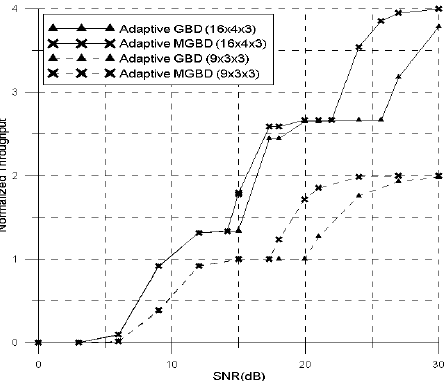
Figure 8. Comparison of the throughput performances for adaptive MGBD and adaptive GBD.